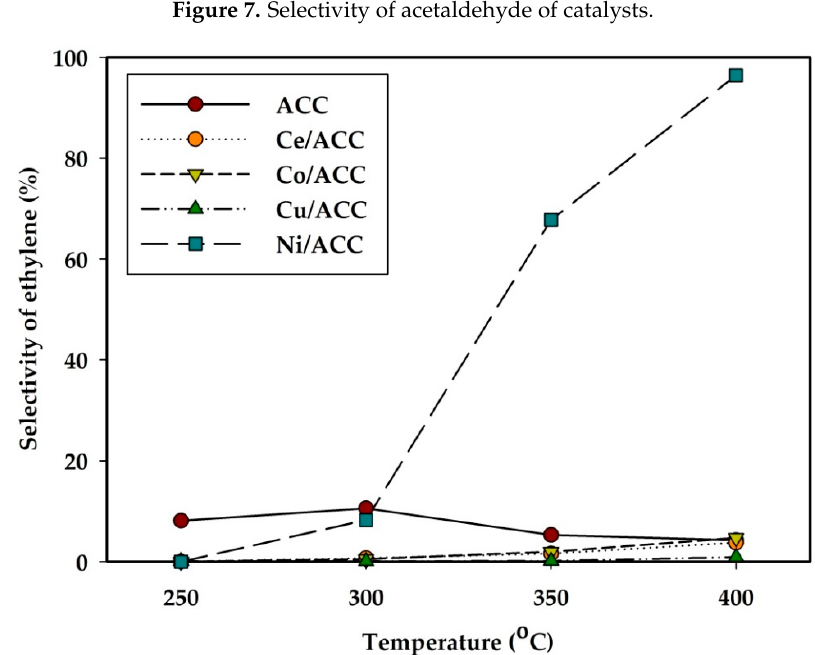
Figure 8. Selectivity of ethylene of catalysts.